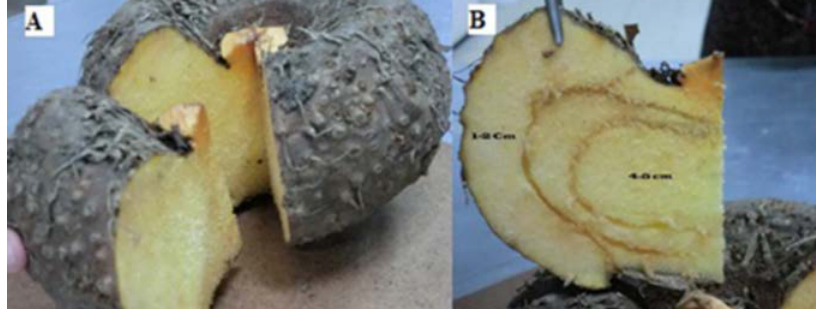
Figure 1. Bulbil position: thick arrow shows a main bulbil; thin arrow marks a side bulbil.